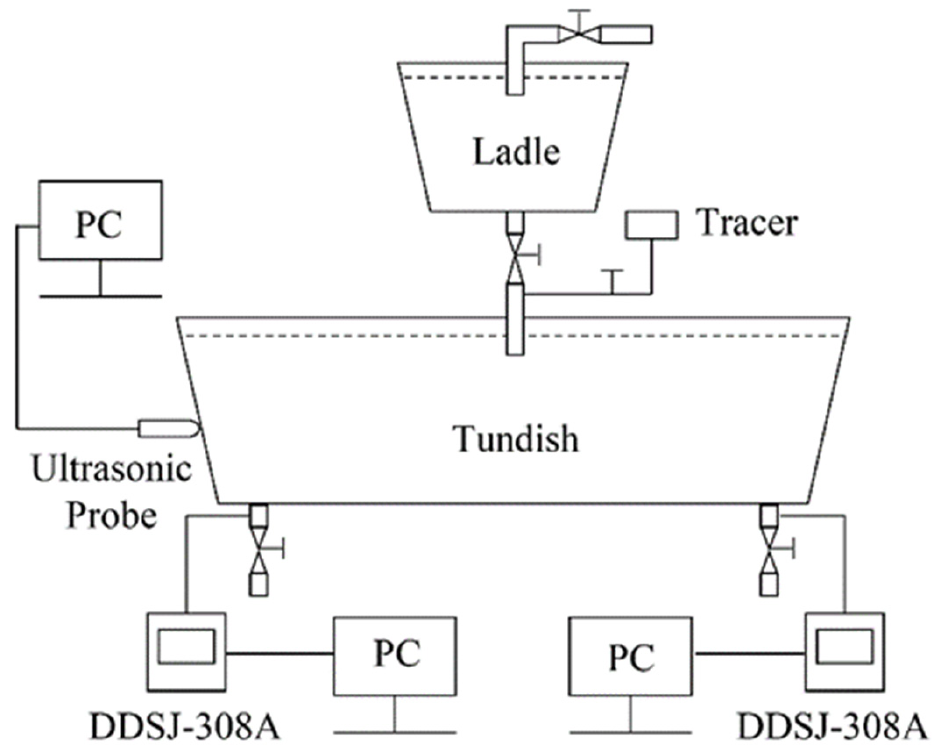
Figure 3. Schematic diagram of experimental setup. PC is the computer for recording data. DDSJ- 308A is the conductivity meter.